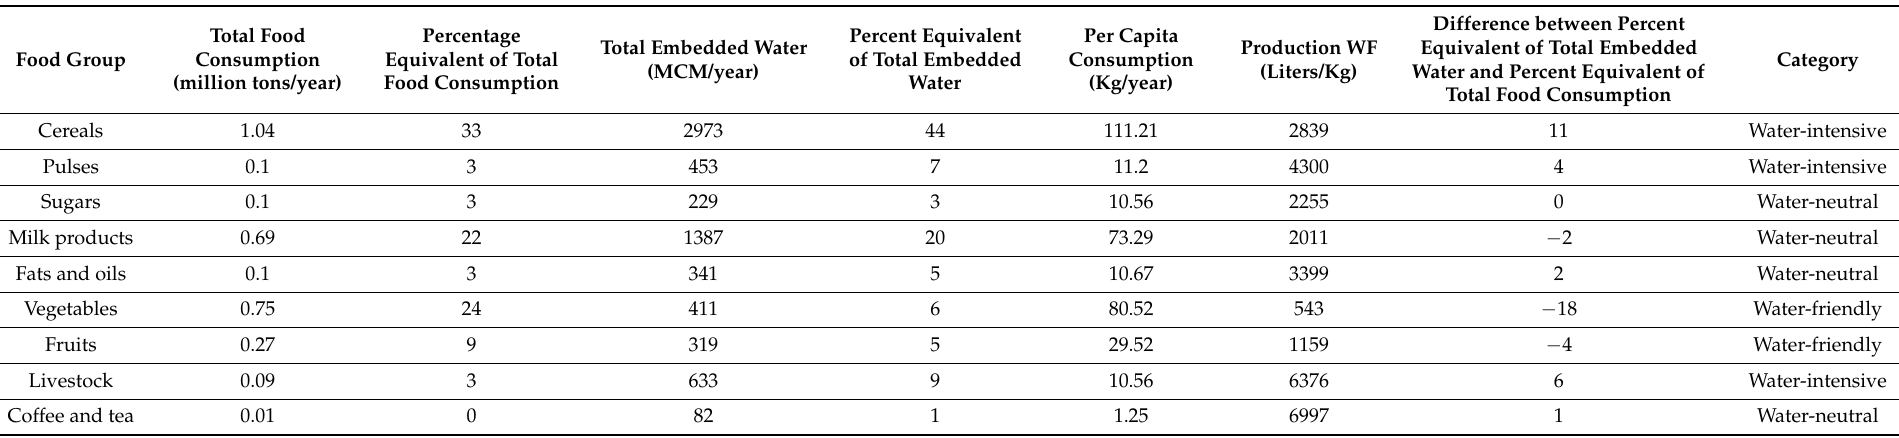
Table 1. Details of total food consumption and its percentage equivalent, total embedded water and its percentage equivalent, per capita food consumption, water production footprint, and category of food groups for the HMDA region (MCM: million cubic